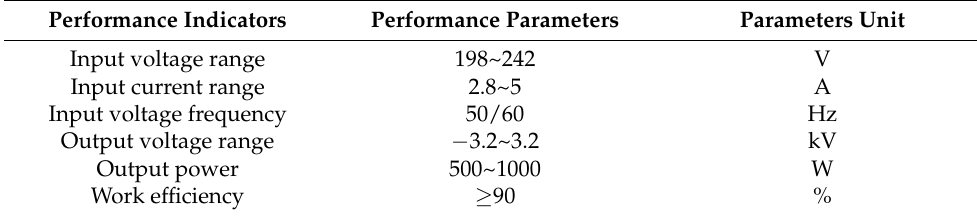
Table 1. Performance index of resonant power supply system for plasma